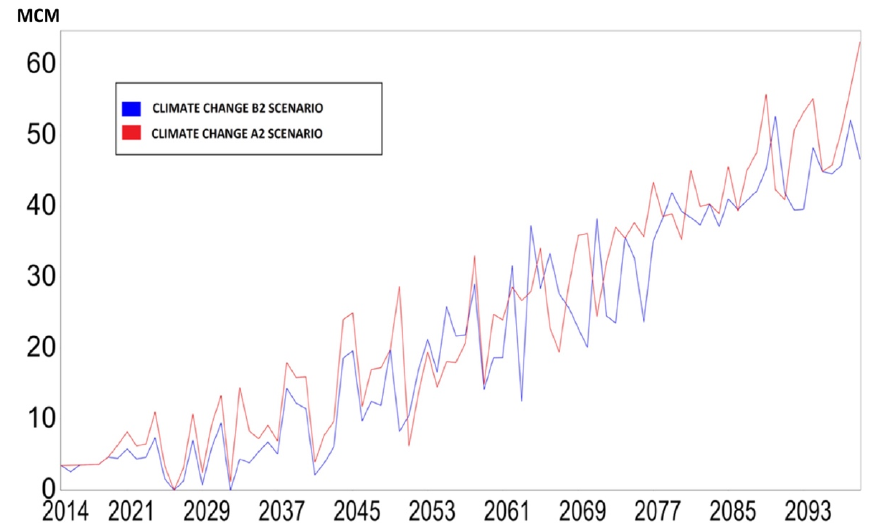
Figure 8. Annual unmet water demand under climate change scenario.